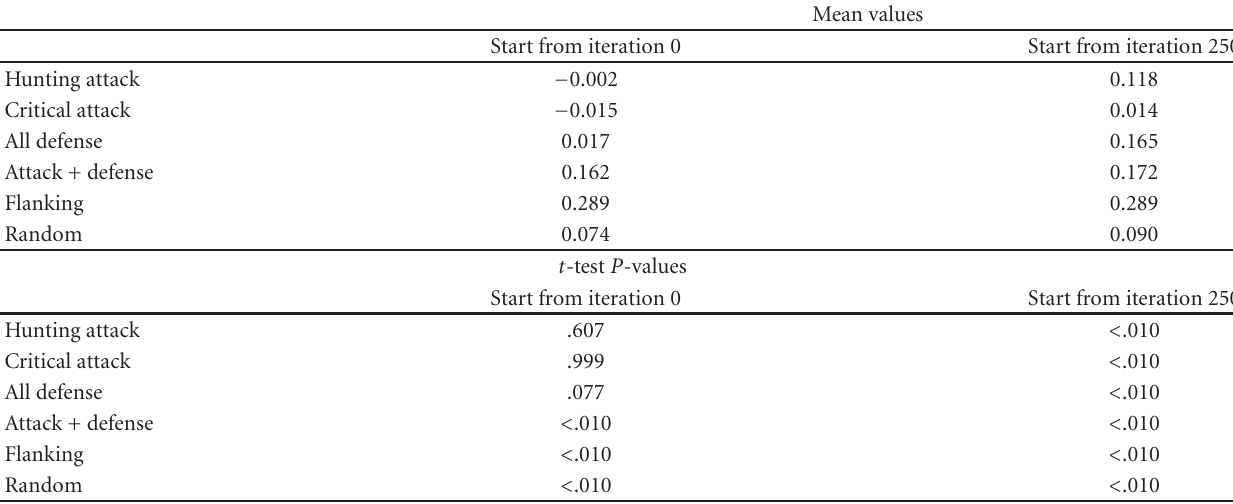
Table 3: Generality test results for the SAP hierarchical learning framework: tables of mean and t -test P -values.